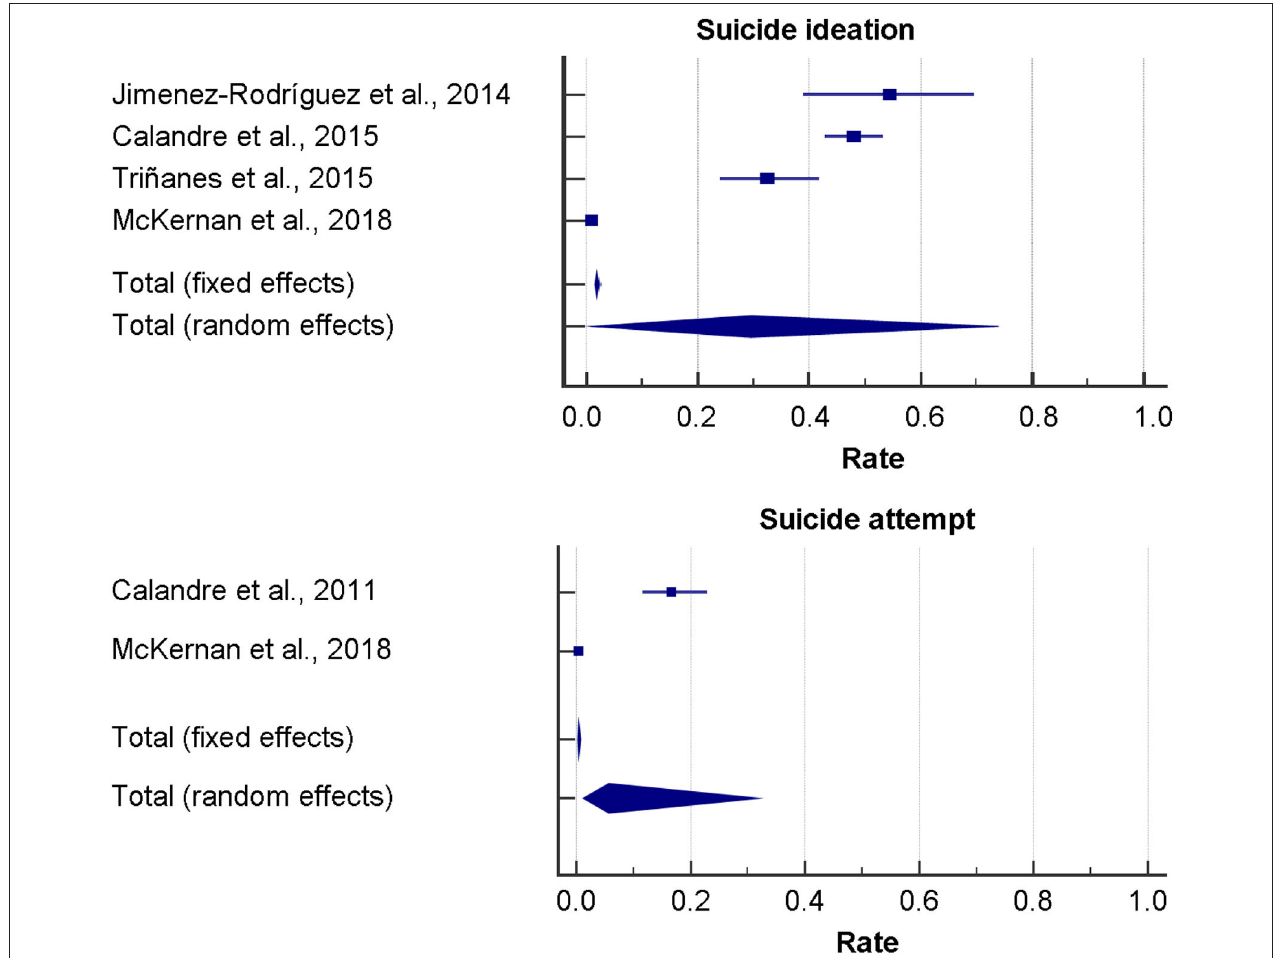
FIGURE 2 | Forest plots of suicide ideation and attempt rates among fibromyalgia patients.